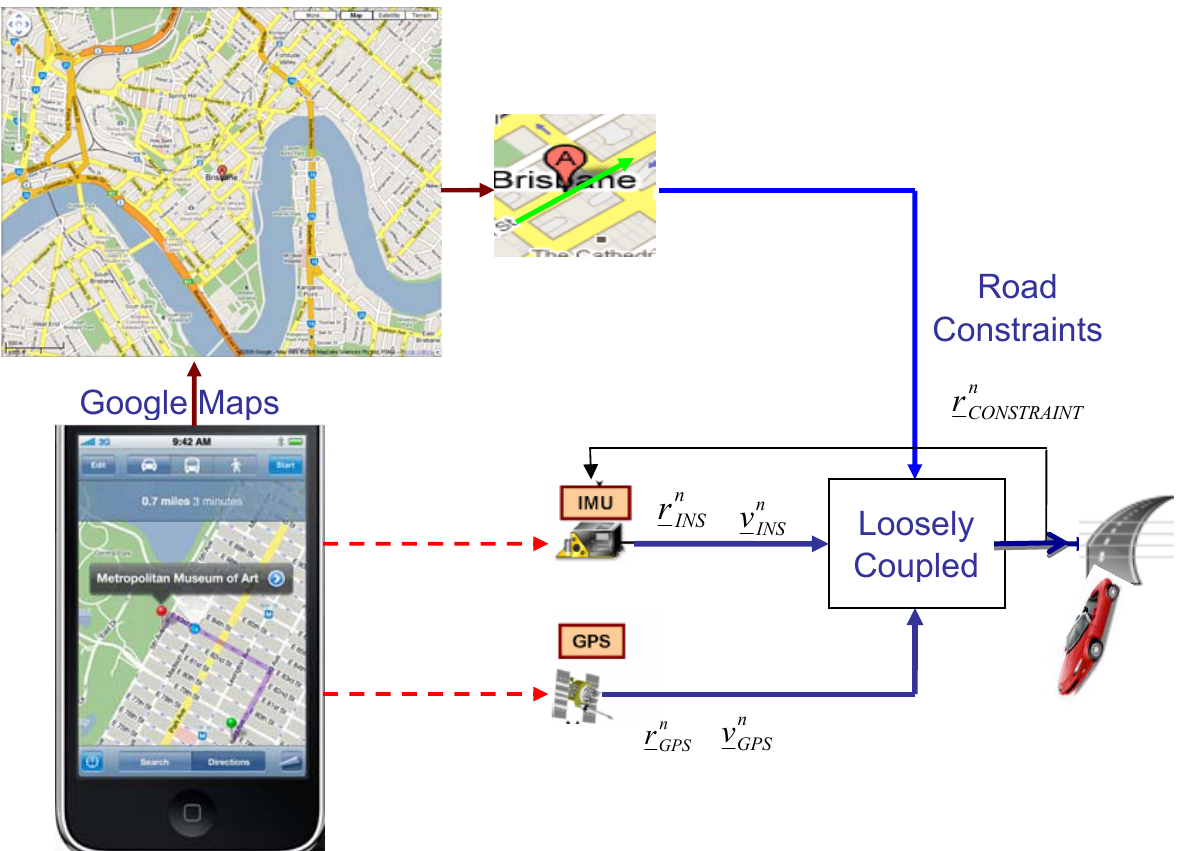
Figure 7. A closed-loop Loosely Coupled GPS/INS integration scheme with